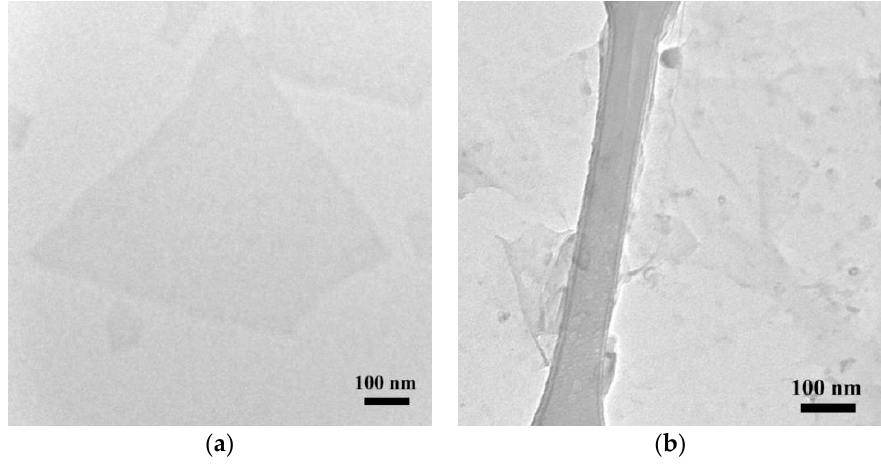
Figure 1. TEM images of ( a ) graphene oxide (GO) and ( b ) PGO.